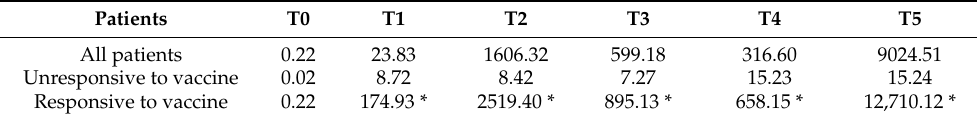
Table 3. The serum IgG levels in the enrolled patients at different times of the study. T0: Admission, I dose of vaccine; T1: II dose of vaccine: 3 weeks after T0; T2: 2 months after T1; T3: 3 months after T2; T4: 6 months after T1, in this time, the patients underwent the III dose of vaccine; T5: 3 weeks after T4, end of the study). We defined unresponsive to vaccine as IgG values < 50 AU/mL. Data are expressed as mean values. * p < 0.01.